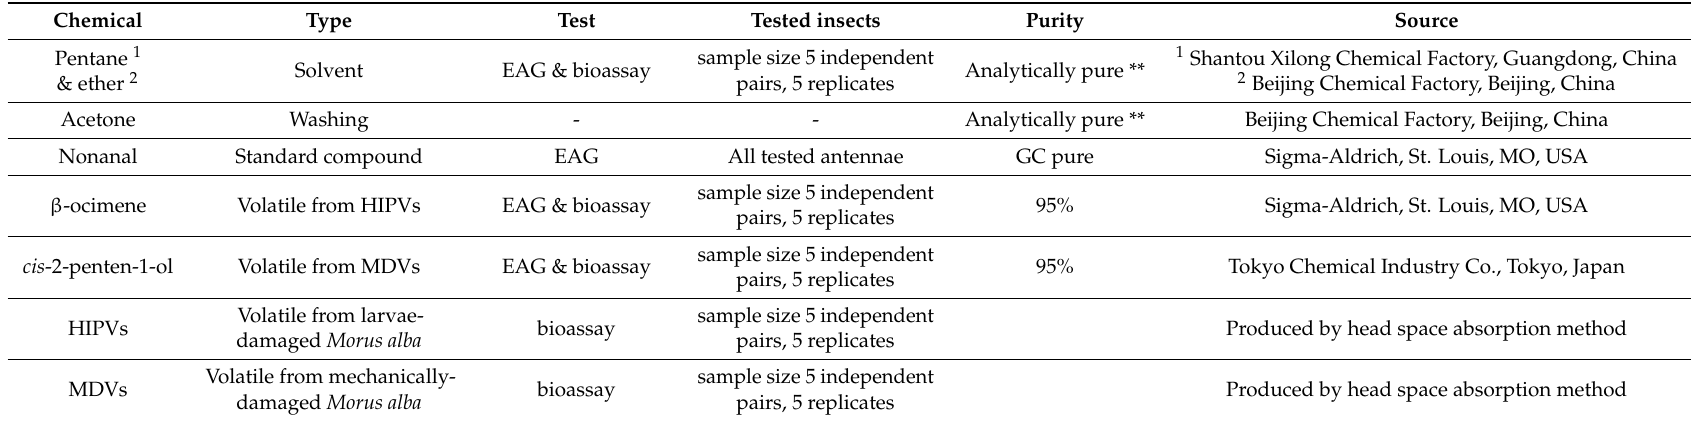
Table 1. Chemicals used in electro-physiological tests as well as in mating and oviposition bioassays. β -ocimene and cis -2-penten-1-ol represent host volatiles, and other chemicals were used as controls, solvents and